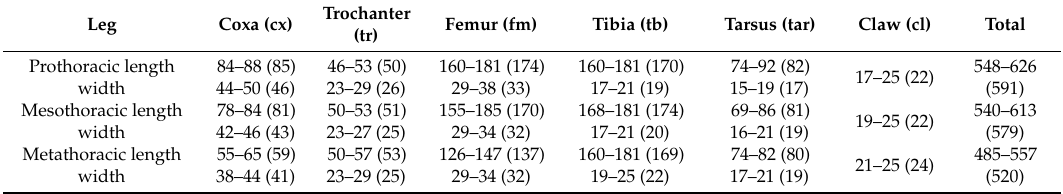
Table 3. Allokermes galliformis (Riley, 1881) leg segment lengths and widths. All measurements are given in micrometers ( µ m). Ranges are displayed, followed by means in